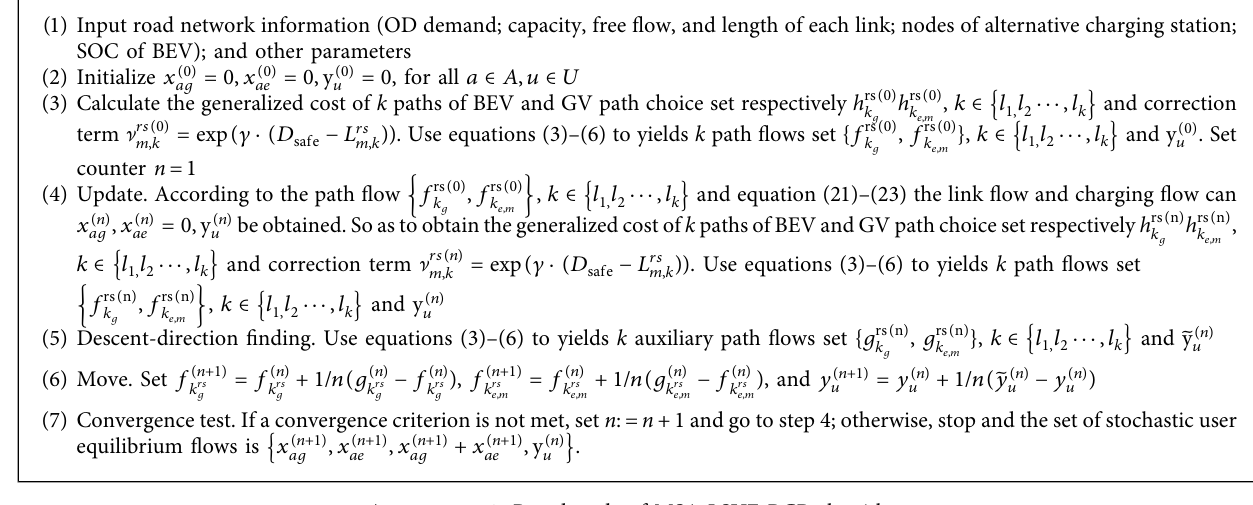
A LGORITHM 1: Pseudocode of MSA-LSUE-RCB